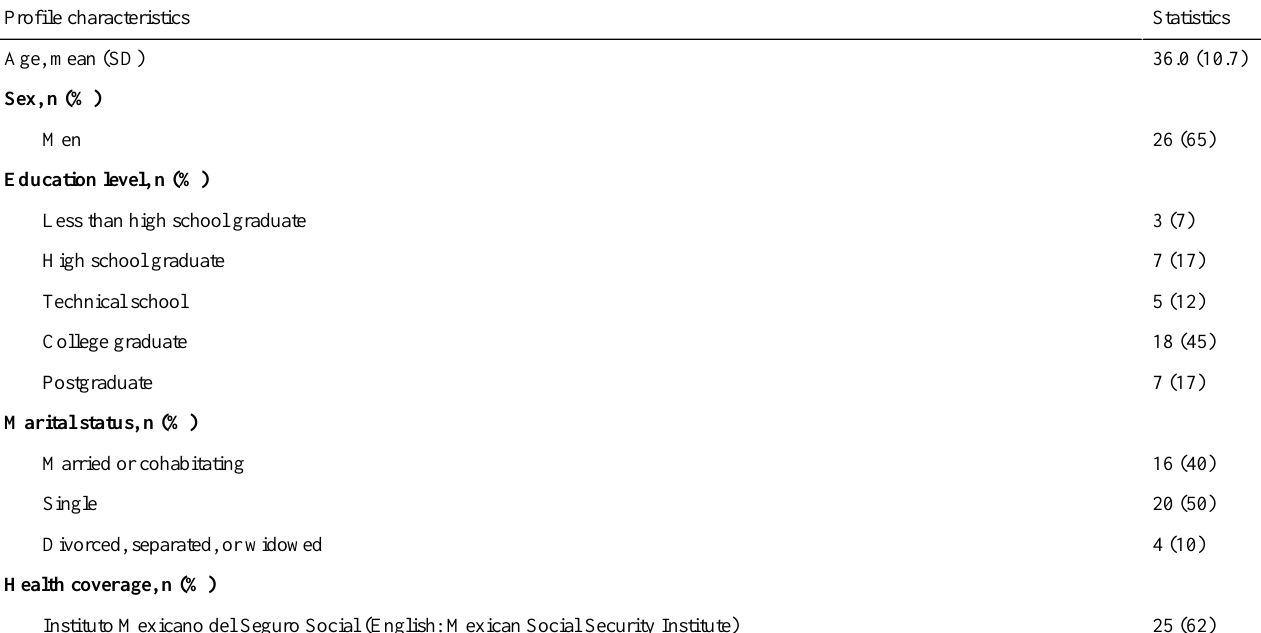
Table 2. Baseline characteristics of participants